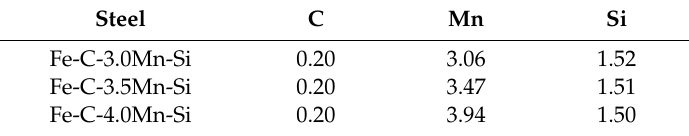
Table 1. Chemical composition of the investigated cold rolled steel